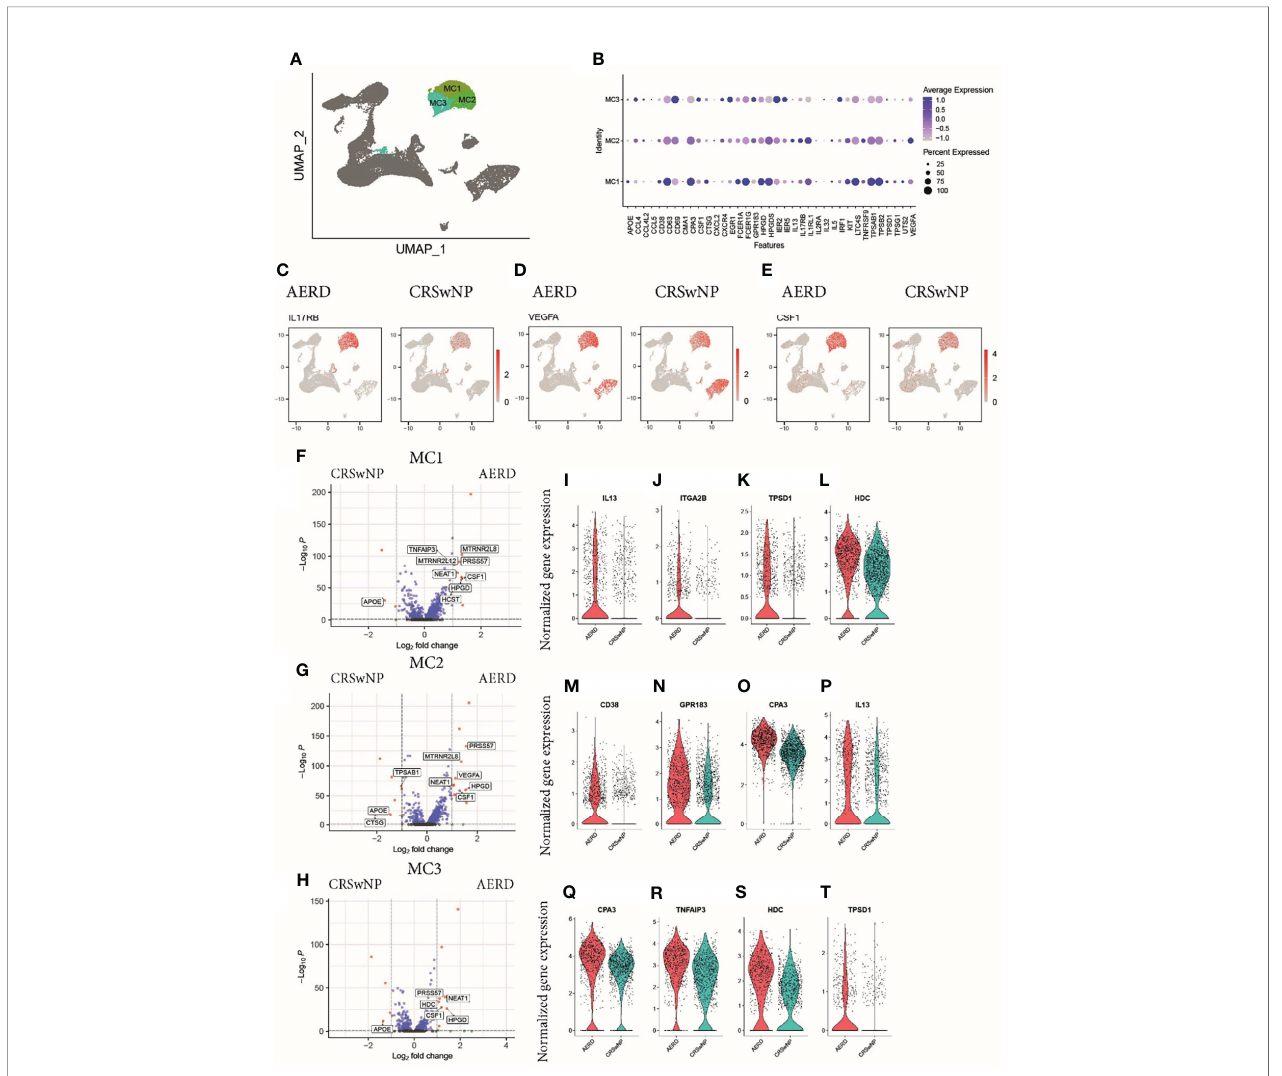
FIGURE 3 | Characterization of mast cellsinpatients with AERDorCRSwNP. (A) Color-coded UMAP plot of scRNA-seqMCsubclusters. (B) Dot plots showing selected marker genes (x-axis) within three mast cellpopulations(MC1 – MC3) displaying the z-score ofthe gene average expression across the three clusters(blue color) and frequency of gene expression (circle size).Feature plots showing natural log-transformed gene expression of (C) IL17RB, (D) VEGFA, and (E) CSF1 inpatients with AERD (left) or CRSwNP (right). (F – H) Volcanoplots displaying differentially regulatedgenes in AERDversus CRSwNP in (F) MC1, (G) MC2, and (H) MC3. Genes with a Bonferroni- corrected p-value <0.05 anda log-fold change >1 are labeled in red. (I – T) Violin plots show natural log-transformed normalized gene expression for selected DEG in AERD (red) versusCRSwNP (blue) patients. AERD, aspirin-exacerbatedrespiratory disease; CRSwNP, chronic rhinosinusitiswith nasal polyps; DEG, differentially expressed genes; MC, mast cell; FDR, false discoveryrate; UMAP, Uniform Manifold Approximation and Projection;scRNA-seq,single-cellRNA